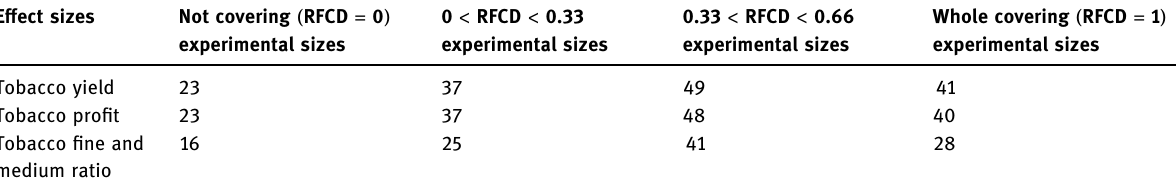
Table 1: Experiment size of di ff erent mulching duration treatments